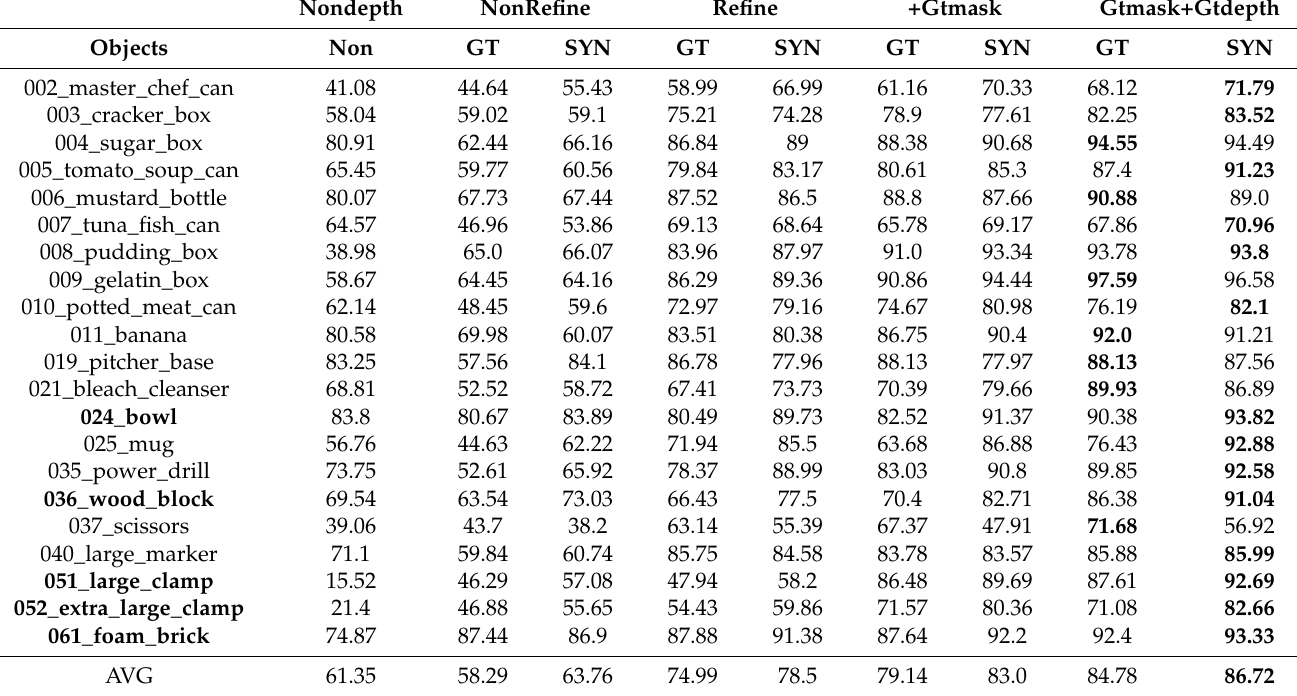
Table 1. Ablation Studies on the YCB-video Dataset. Nondepth is the result without using the translation estimation module. Nonrefine is the result without using the depth refined module. Refine is using the depth refined module. +gtmask uses ground truth masks. +gtdepth uses ground truth depth. GT is the result of using ground truth depth maps. SYN uses synthetic depth maps. Objects in bold are symmetric. We calculate the ADD Area under Curves (AUC) for non-symmetric objects and the ADD-S AUC for symmetric